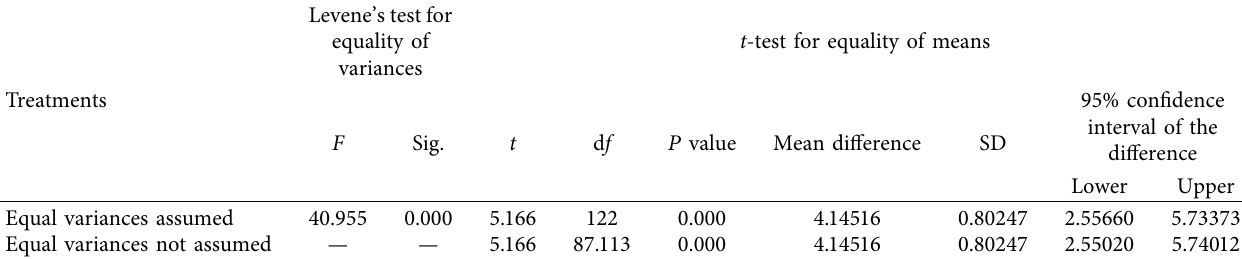
Equal variances assumed Equal variances not assumed